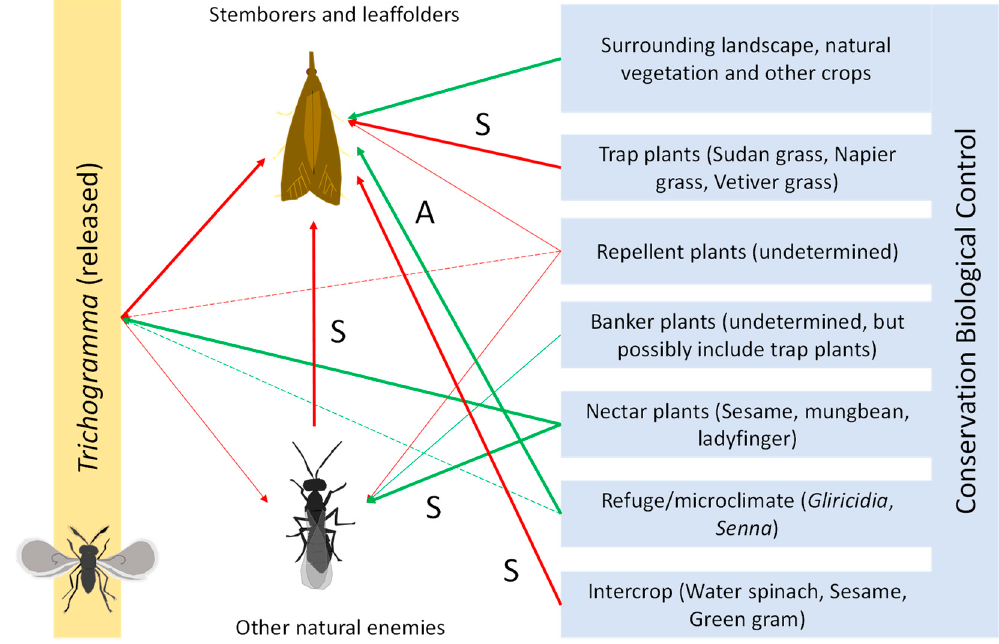
Figure 6. Summary of available technologies to support the integration of augmentative and con ‐ servation biological control of leaffolders and stemborers in rice. Green arrows indicate positive effects on Lepidoptera pests or their natural enemies of various habitat manipulations based on published reports. Red arrows indicate potential negative effects. The thickness of arrows relates to available evidence in published studies; thick = good evidence, dotted = suggestive only. ‘S’ indicates a probable synergy between the inundative release of parasitoids and conservation biological control; ‘A’ indicates possible antagonistic effects. Results suggest that trap plants, certain nectar plants, and certain intercrops are compatible with augmentative biological control. Naturally occurring predators and parasitoids may also function synergistically with laboratory ‐ reared Trichogramma by, for example, attacking life ‐ stages of the pests, other than eggs. They may also compete for available eggs, or predators may kill developing Trichogramma larvae during egg predation; however, such negative interactions will probably reduce the profitability (i.e., redundancy, but not antagonism) of releasing Trichogramma , but will not reduce overall biocontrol services.